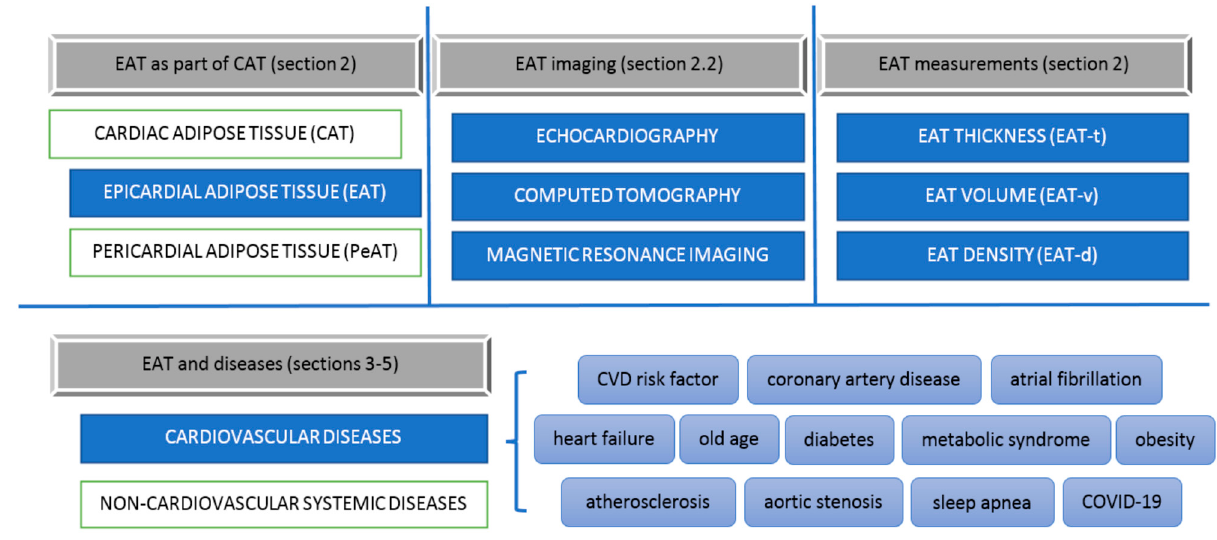
Figure 3. Epicardial adipose tissue—resume.